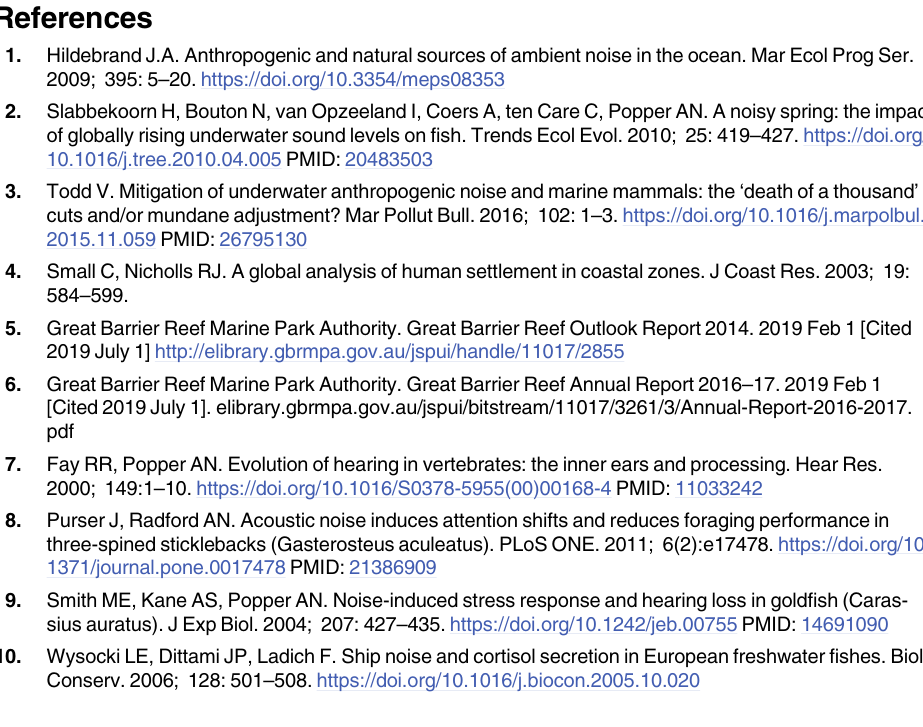
S1 Table. Details of ambient, 4-stroke boats and ship recordings used in playback experi- ments. S2 Table. Summary of logistic regression comparing the number of responsive individuals among acoustic treatments. S3 Table. Tukey test for